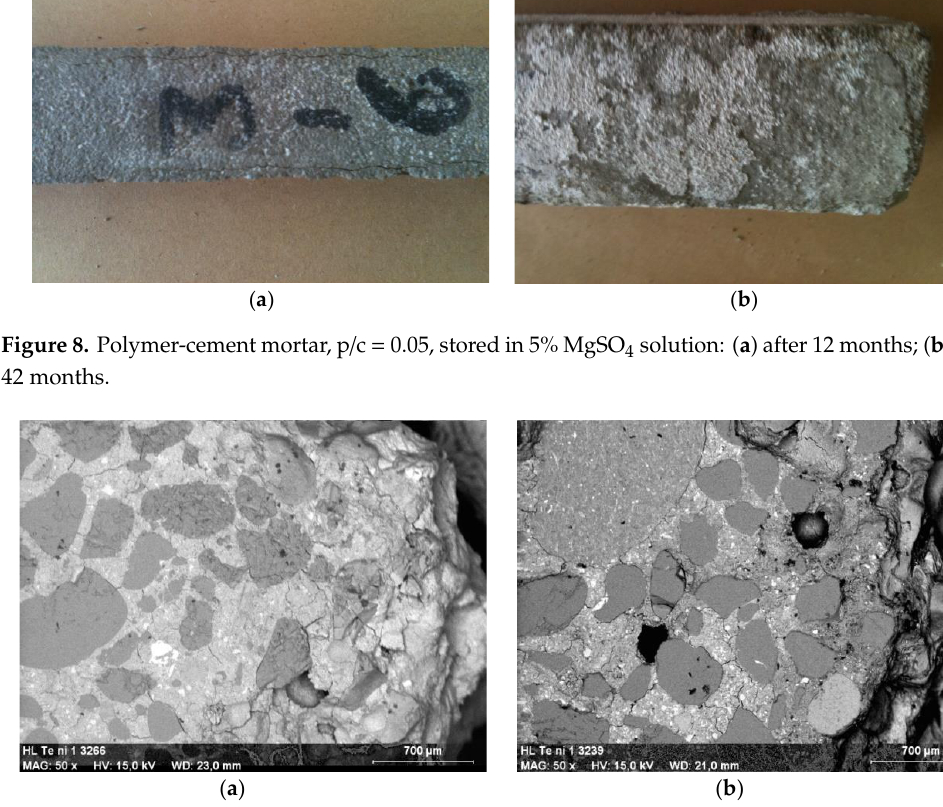
Figure 9. Microscopic images of polymer-cement mortar, p/c = 0.05, stored in 5% MgSO 4 solution: ( a ) after 12 months; ( b ) after 42 months.